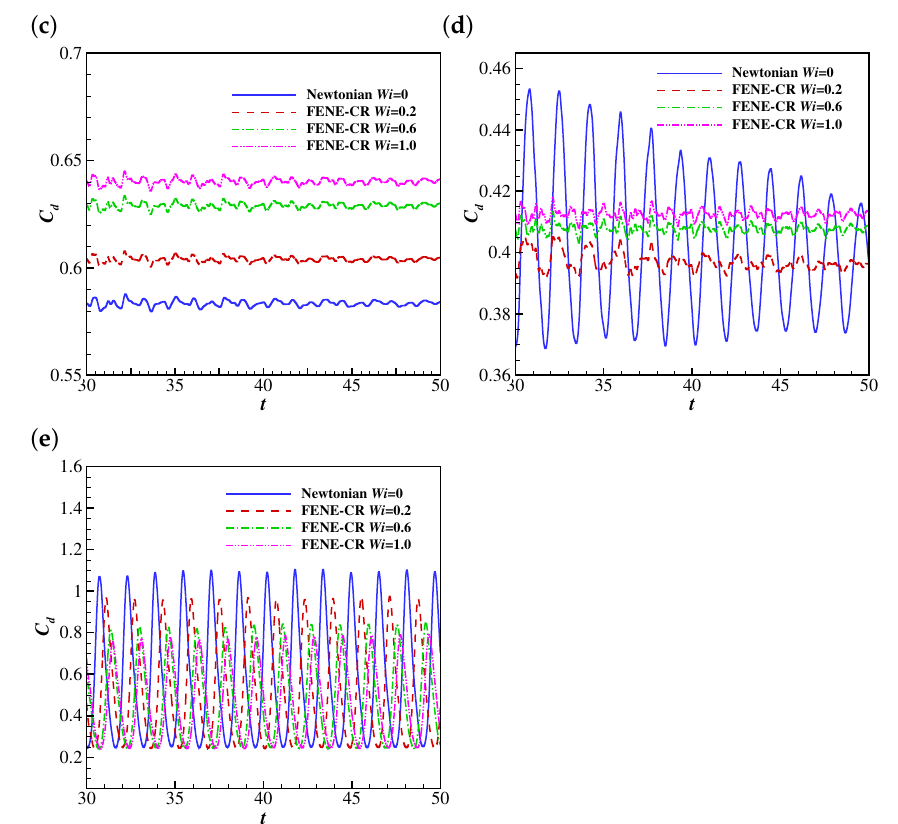
Figure 15. The time histories of the drag coefficient on the filament in Newtonian and FENE-CR uniform flows at Re = ( a ) 10, ( b ) 25, ( c ) 50, ( d ) 100 and ( e ) 200.